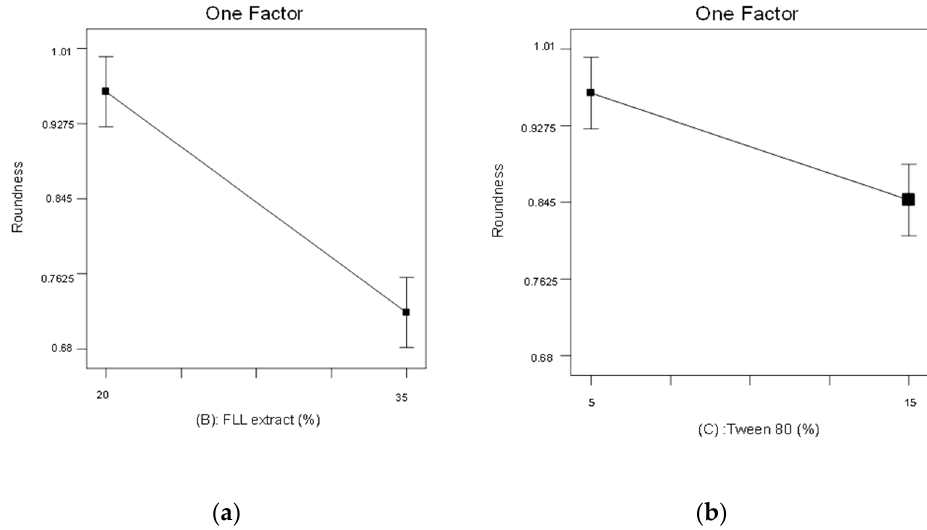
Figure 7. Using the 2 3 factorial experimental design to evaluate the significant effects of factors B and C on roundness ( p < 0.05). ( a ) factor B: FLL extract loading, ( b ) factor C: Tween 80